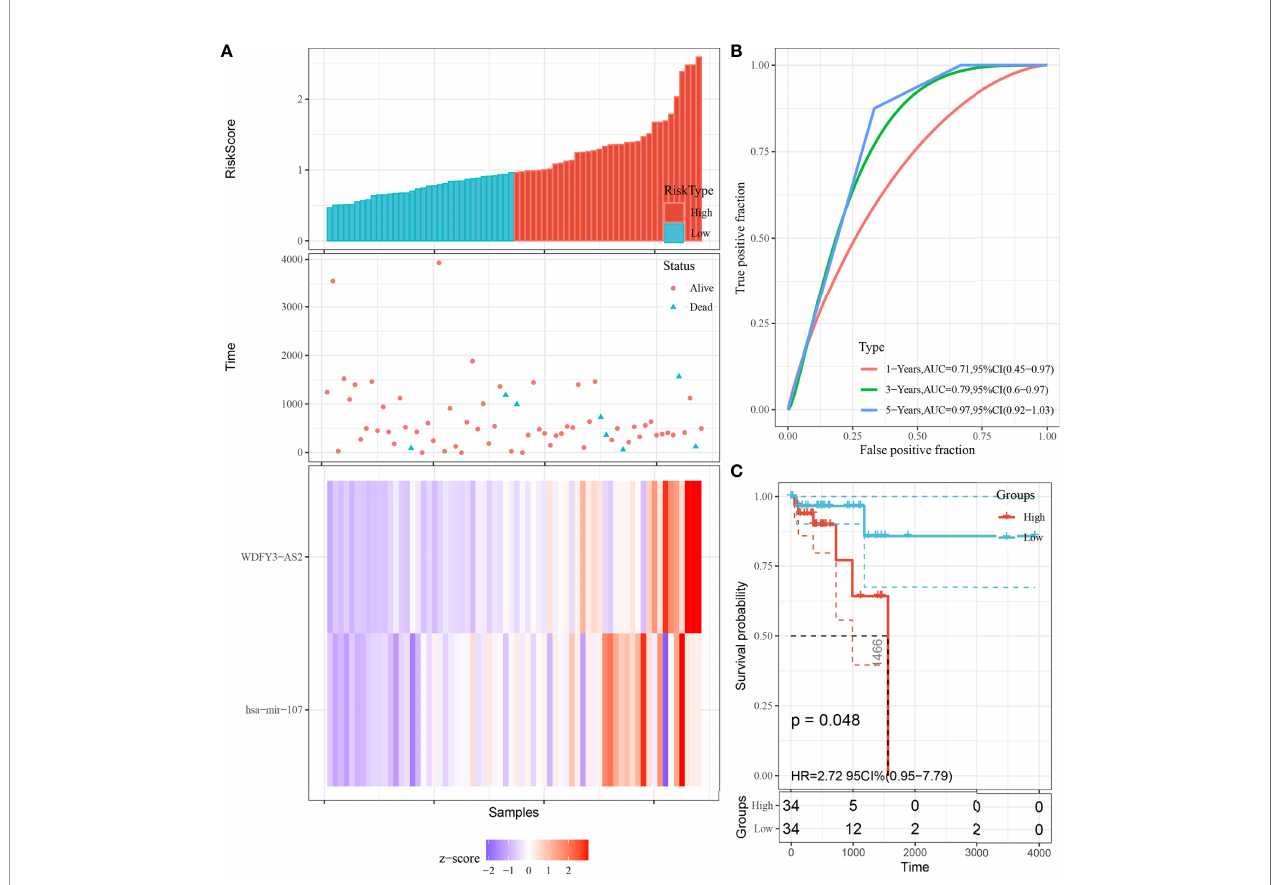
FIGURE 7 | Construction of the prognostic model based on survival-related biomarkers. (A) Risk score distribution in RC patients. Red dots and lines represent the high-risk group of the model, and blue dots and lines represent the low-risk group of the model. (B) ROC curves of 1-, 3- and 5-year survival rates of RC patients. The red line represnts the 1-year survival rate of RC patients, the green line represents the 3-year survival rate, and the blue line represents the 5-year survival rate. (C) K – M plot of the risk score survival